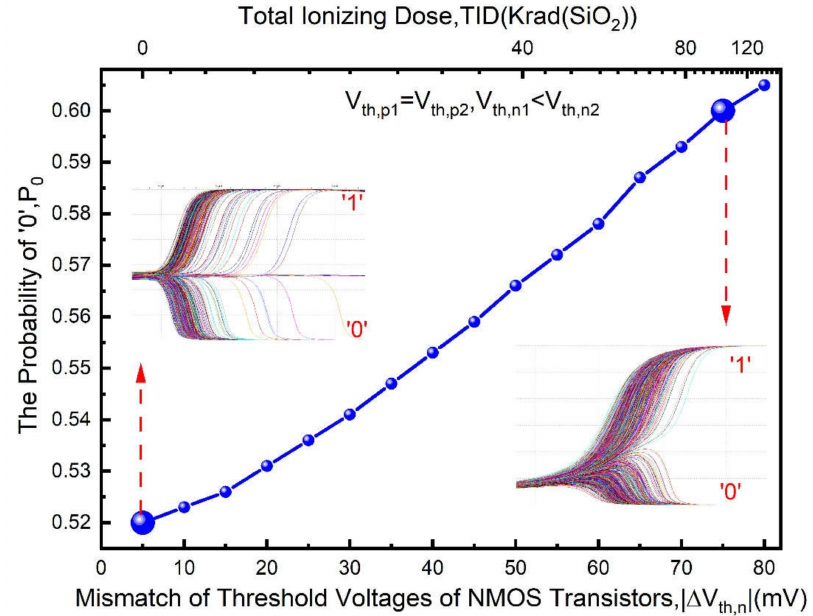
Figure 7. Simulation results for a weak cell ( V th , n 1 < V th , n 2 ), its initialized value faintly tends to 0.